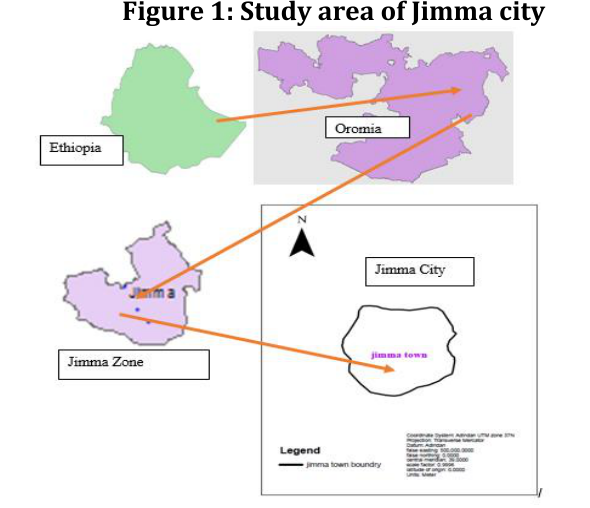
Source : Extracted from